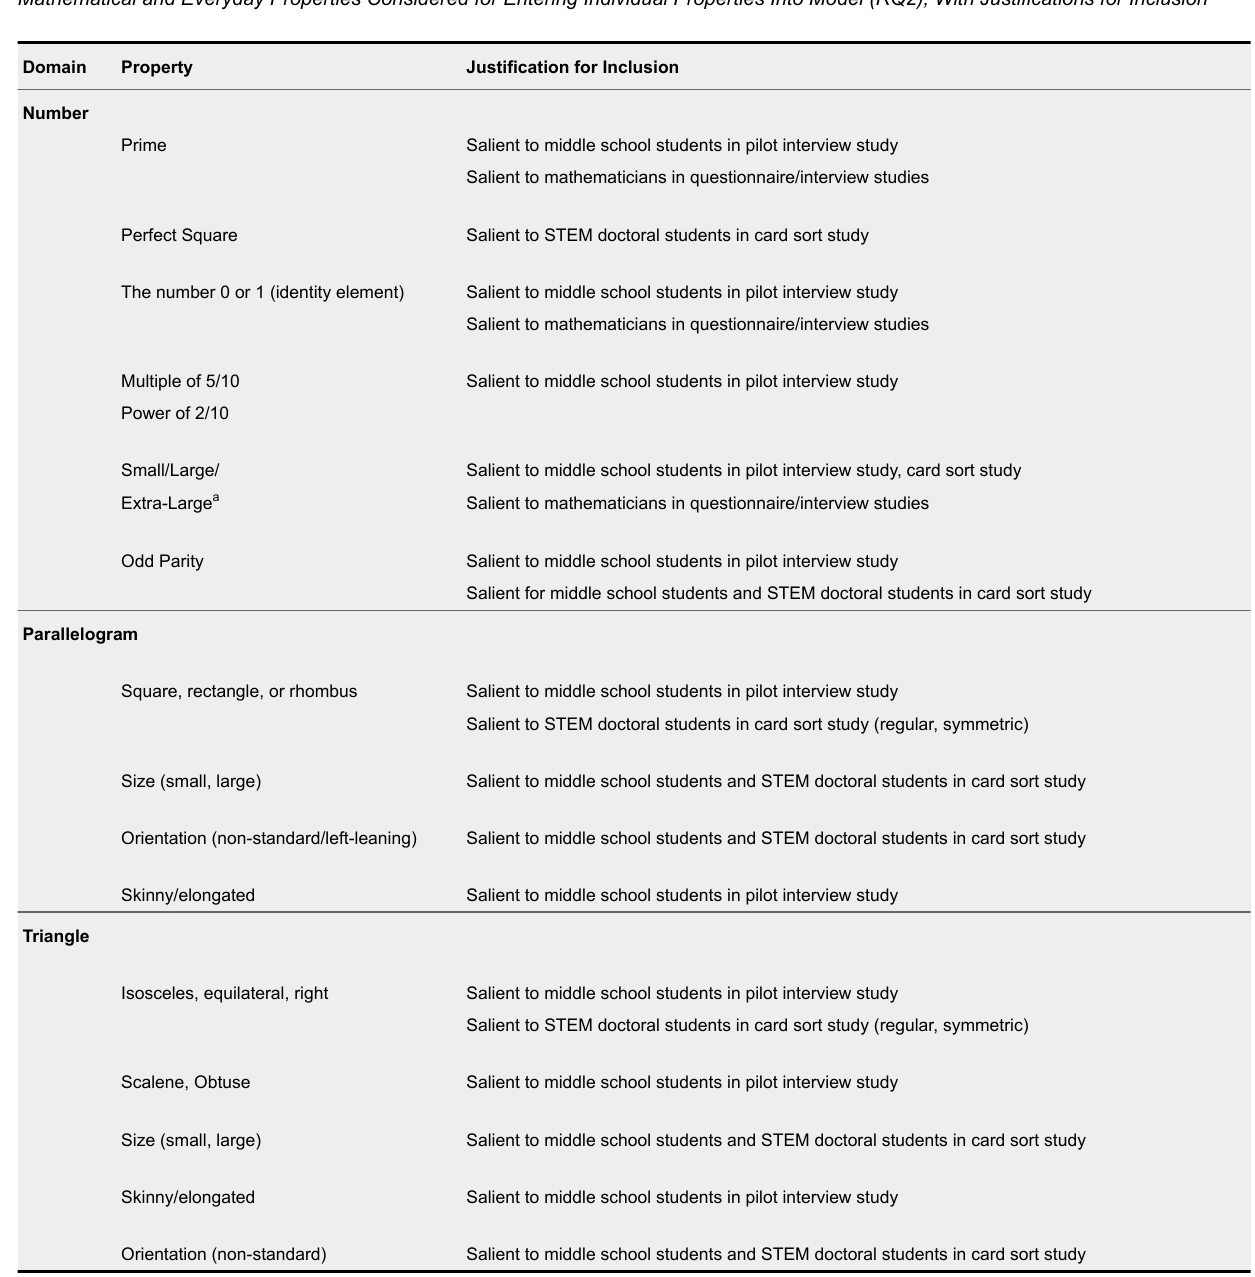
Mathematical and Everyday Properties Considered for Entering Individual Properties Into Model (RQ2), With Justifications for